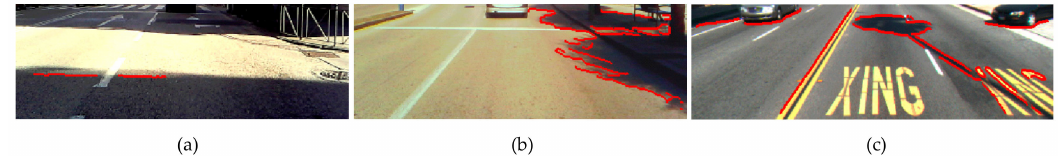
Figure 20. Detection errors: ( a ) oversaturated road region; ( b ) shadow underneath a vehicle; ( c ) yellow marking